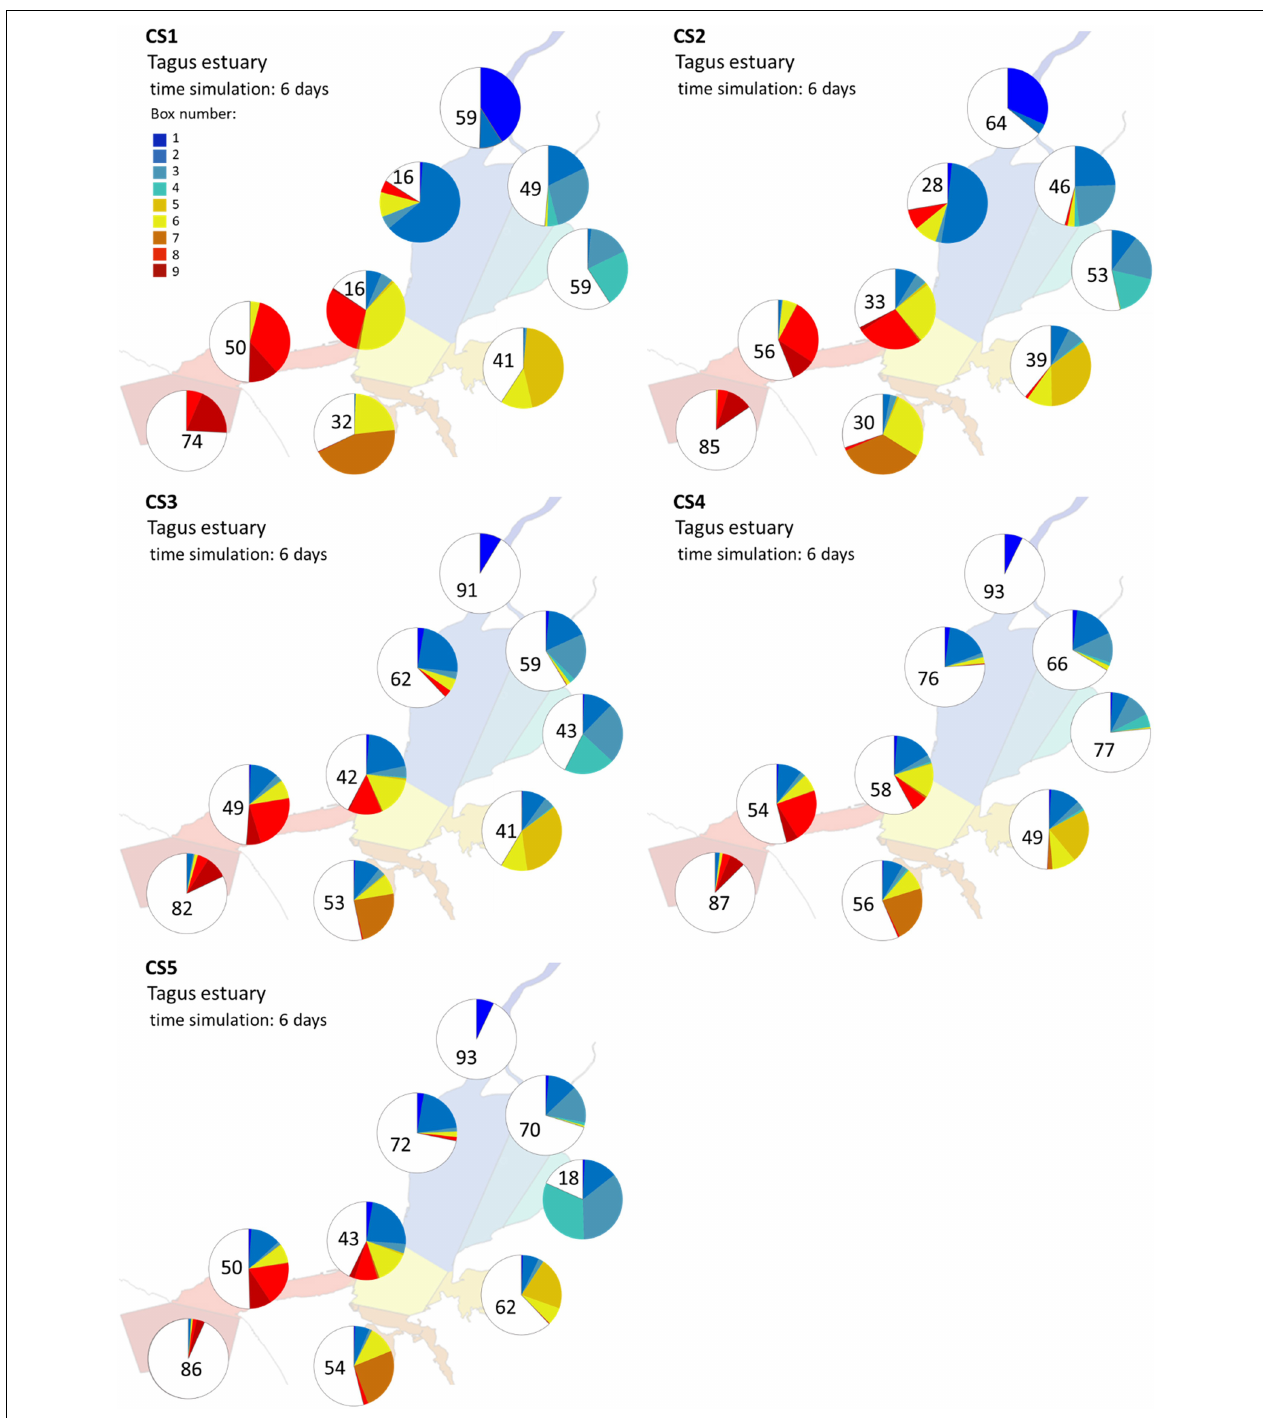
FIGURE 7 | Integrated contribution in each box after 6 days of simulation. White slice corresponds to new water (from river or/and seawater).